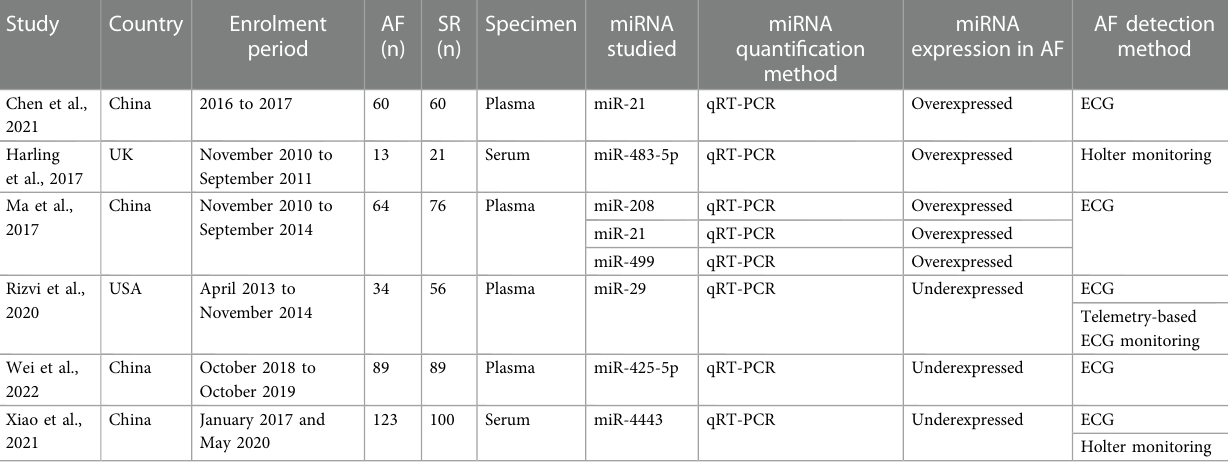
TABLE 1 Baseline characteristics of the included